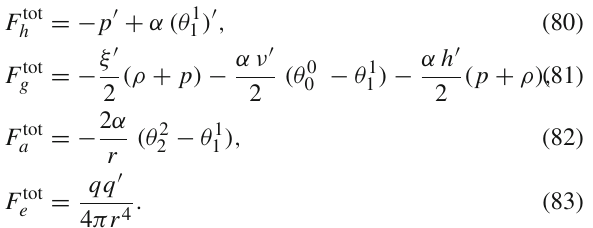
Fig. 13 Thevariationoftotalenergydensity( ρ tot )versusradialcoordi- nate r / R for different values of decoupling constant. The same constant values have been taken to plot this graph as used in Fig.